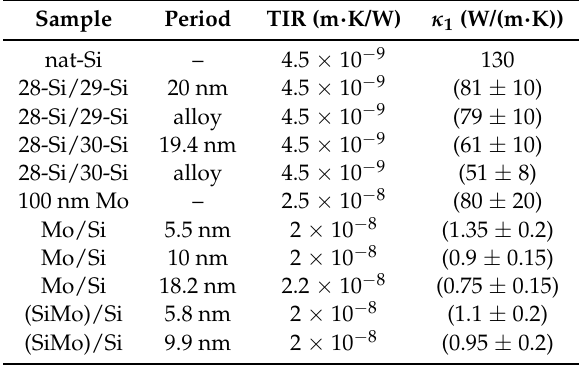
Figure 6. Comparison of the measured thermal conductivities of the silicon isotope multilayers of molecular dynamics calculations as a function of the periodicity of the stack (Frieling et al., [59]). The horizontal lines mark the simulation result for natural silicon (black line) and for the random 28 Si 30 Si 0.5 / 0.5 alloy (blue dashed line). The lower part of the figure contains experimental data from the Si/Mo multilayers. The curved lines indicate an effective conductivity as a sum of TIR of the individual layers for the isotope modulation and the Si/Mo stacks (lower green thick lines), respectively. Table 1. List of all used thin-film structures with the multilayer period, TIR at the interface gold-layer and the determined effective thermal conductivity of the full layer